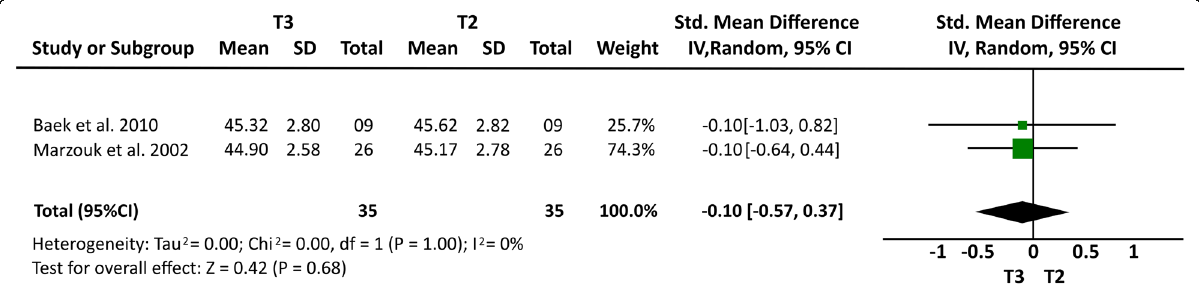
Fig. 6 Forest plot U1-PP difference between T2 and T3 in patients who used TADs for molar intrusion after 1-year follow-up. 95% confidence interval and 95% prediction